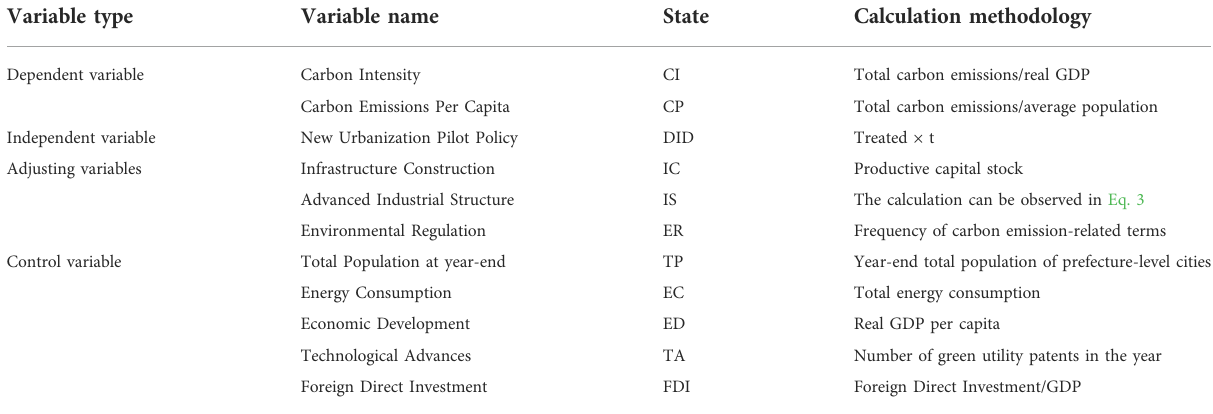
TABLE 1 Variable selection and